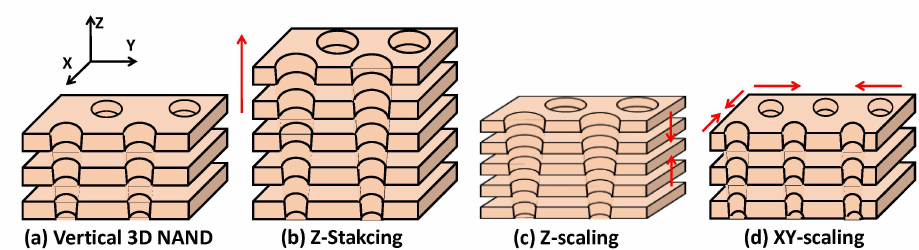
Figure 1. ( a ) 3D bird’s-eye view of vertical 3D NAND flash memory. There exist three ways to increase the memory density, i.e., ( b ) increasing the number of stacks in z-direction, ( c ) decreasing the thickness of each stack, and ( d ) decreasing the cell-to-cell pitch in the xy-plane.